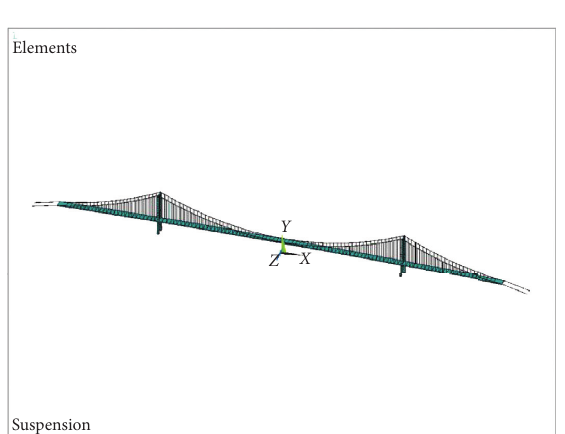
Figure 6: Finite element model diagram of the whole suspension bridge.